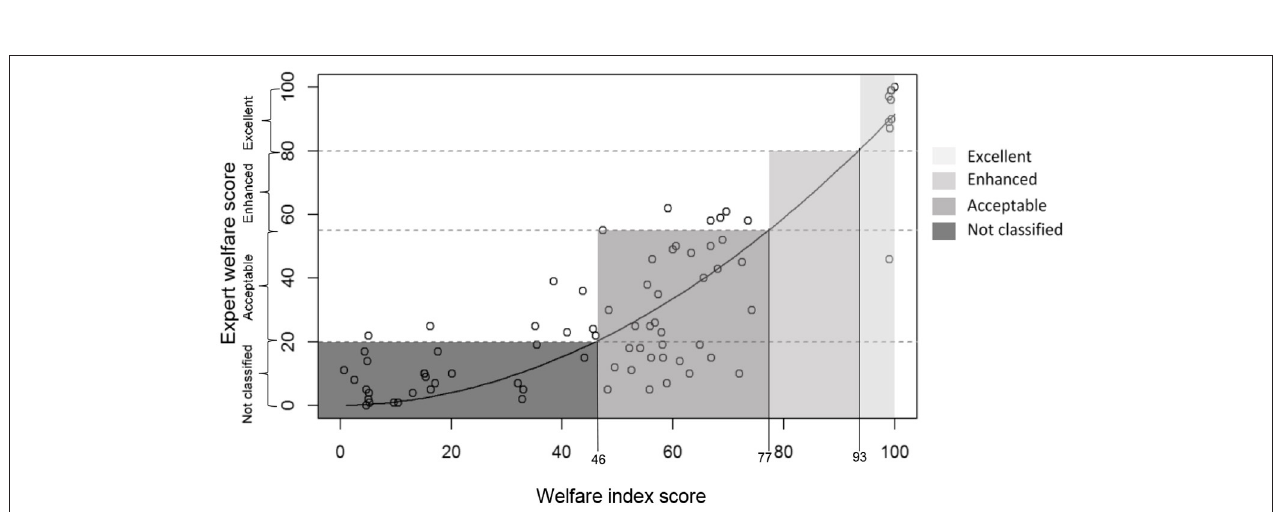
FIGURE 5 | Expert (n = 14) welfare scores of the fictitious herds (n = 12) plotted against the calculated WI scores of these herds using no CRM, with best fitting quadratic curve (R 2 = 0.91). Higher scores indicate better welfare; category thresholds determined using the expert scores are indicated underneath the x-axis.